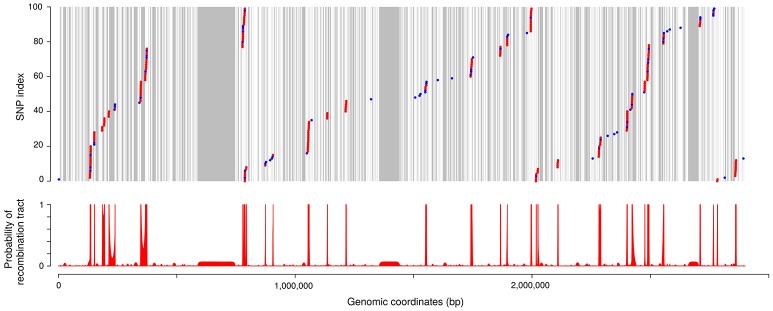
SNPs and recombination tracts between two closely related isolates. The strains compared here are JIP 02/86 and CH1895. (Upper) Positions of the SNPs along the genome (using the genomic coordinates of CSF259-93 as references). SNP index is reset every 100 SNPs for this representation. Each dot represents one SNP between the two isolates. Colors distinguish two types of polymorphism: in blue, polymorphism observed only inside CC-ST10 (referred to as polymorphism of type P1 in the text); in red, polymorphism observed also outside of CC-ST10 (polymorphism of type P2). Areas in gray correspond to regions not covered by our alignments. (Lower) Probability of recombination tract as computed with the HMM.